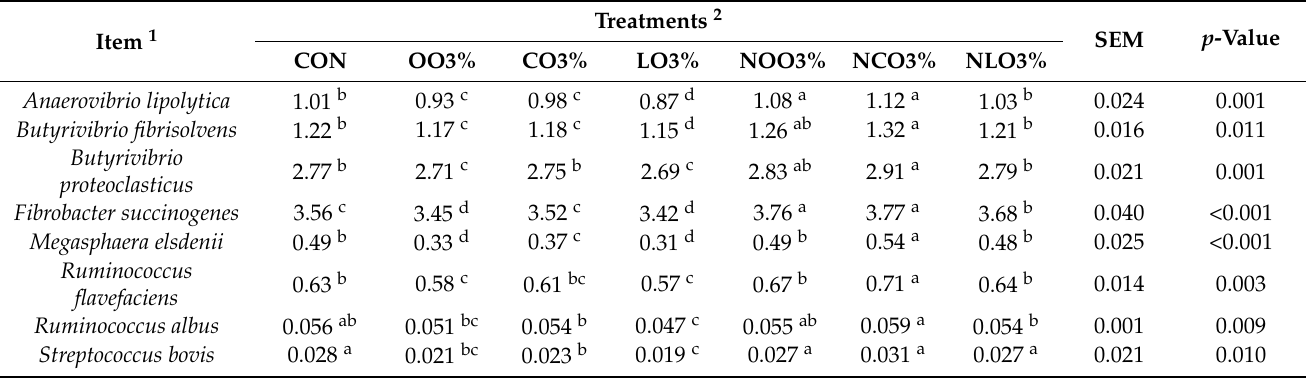
Table 8. Effect of the supplementation of raw and nanoemulsified olive oil, corn oil, and linseed oil on ruminal microbial populations quantified using quantitative